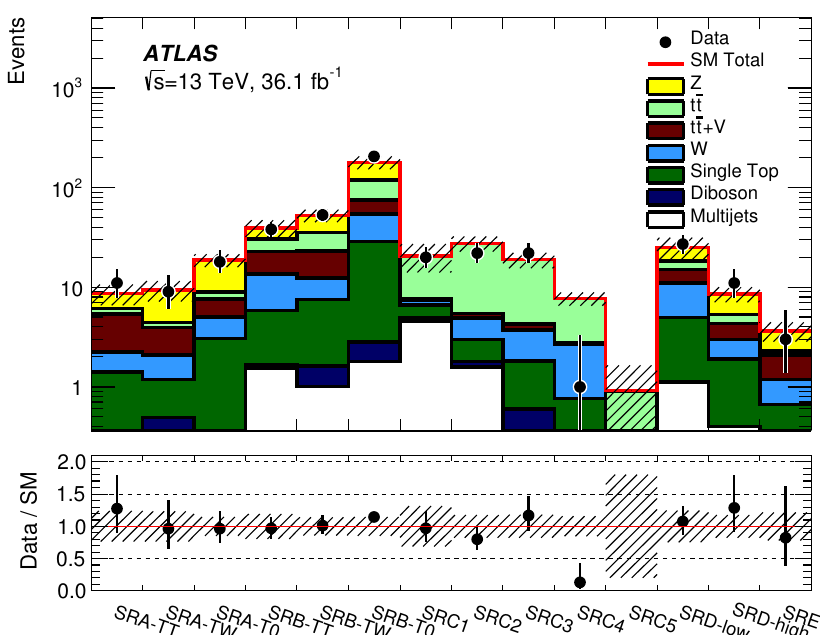
Figure 6. Yields for all signal regions after the likelihood (cid:12)t. The stacked histograms show the SM prediction and the hatched uncertainty band around the SM predicttion shows total uncertainty, which consists of the MC statistical uncertainties, detector-related systematic uncertainties, and theoretical uncertainties in the extrapolation from CR to